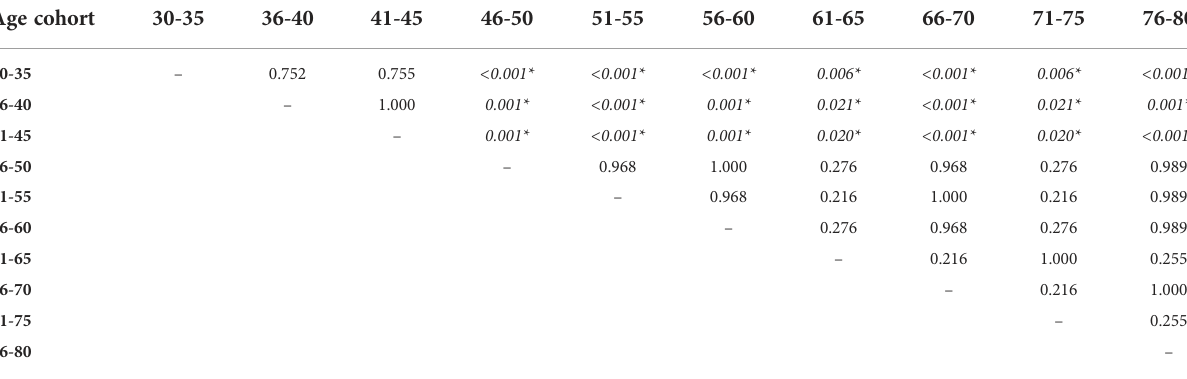
TABLE 3 The signi fi cance of differences in the proportion of people with VNA ≥ 1/20 depending on the age cohort.